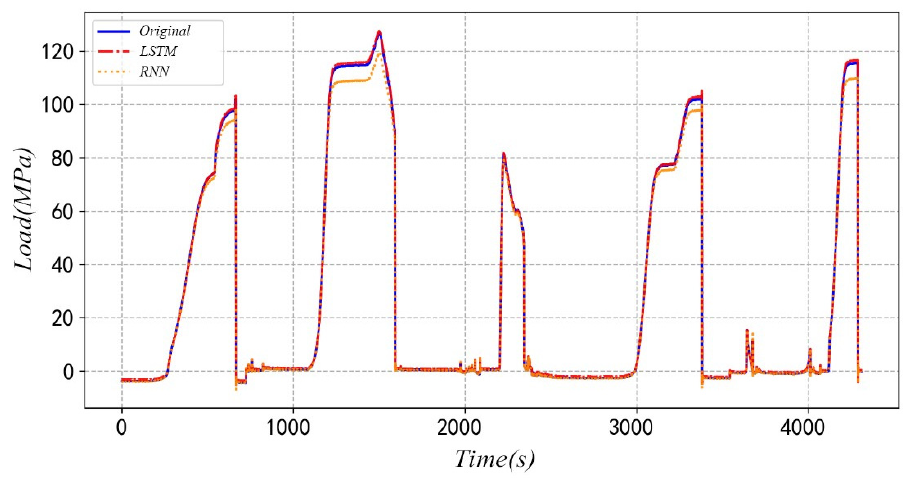
Figure 8. Comparison of forecast results and original data.